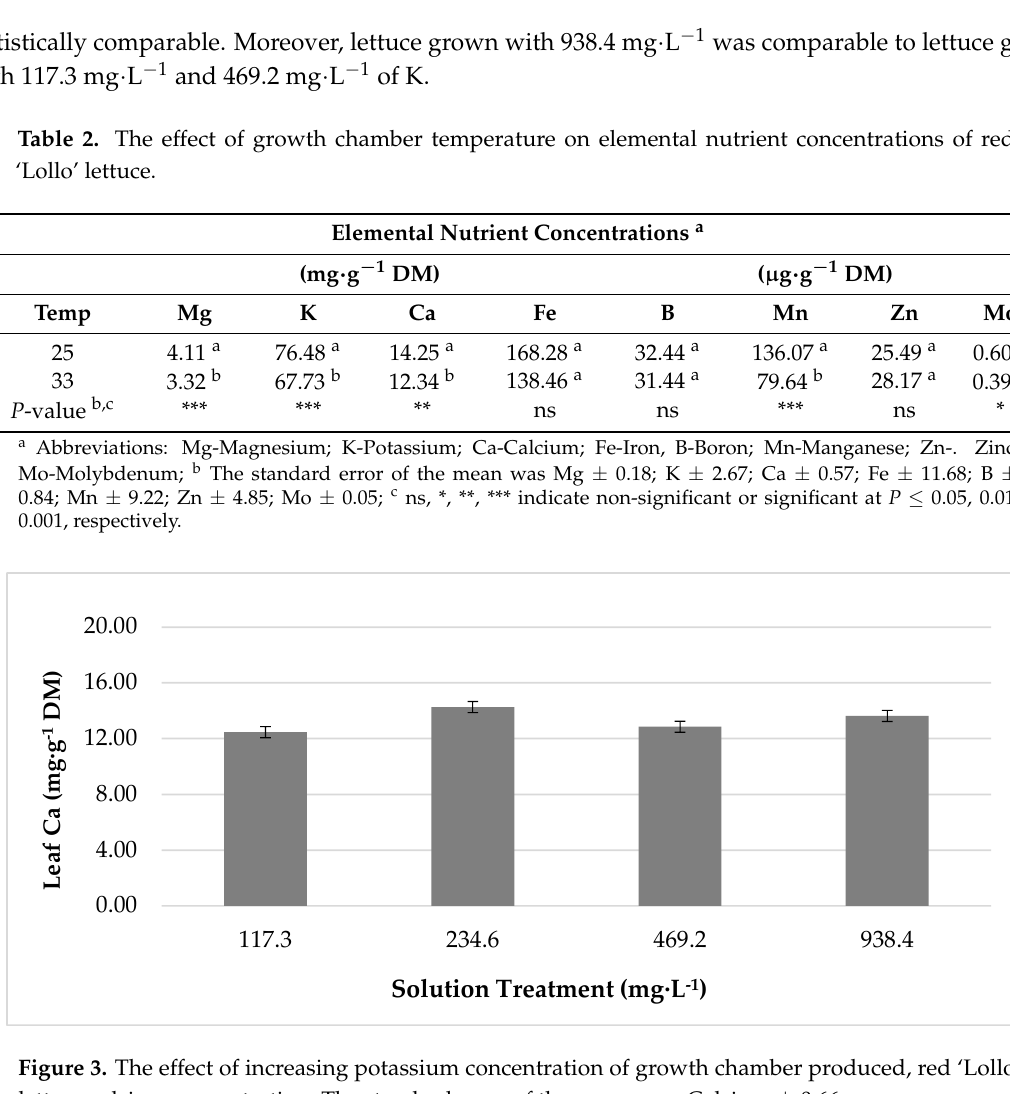
Table 3. The effect of the interaction between temperature and treatment on elemental nutrient concentrations of growth chamber red ‘Lollo’ lettuce.